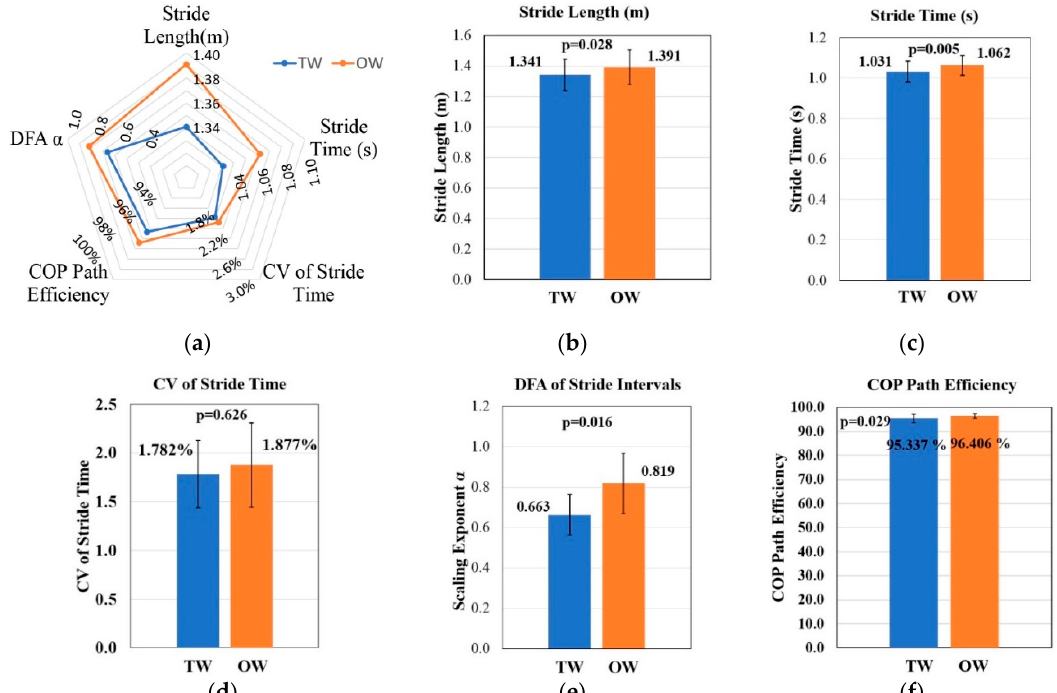
Figure 3. ( a ) Contrast of spatiotemporal parameters between TW and OW condition. ( b ) Contrast of stride length. ( c ) Contrast of average stride time. ( d ) Contrast of CV of stride time. ( e ) Contrast of fractal dynamic of stride intervals. ( f ) Contrast of COP path efficiency.